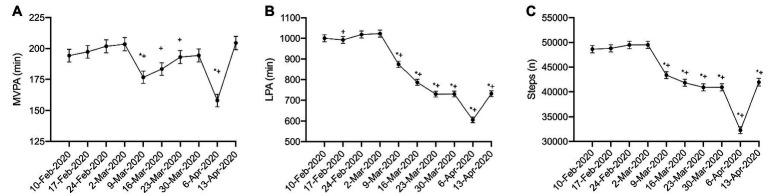
Physical activity during physical distancing. (A) moderate-to-vigorous physical activity (MVPA); (B) light physical activity (LPA); (C) Steps; (*) represented significant difference from 10-Feb-2020; (+) represented significant difference from 2-Mar-2020. For clarity, only selected significant differences are indicated on the figure.